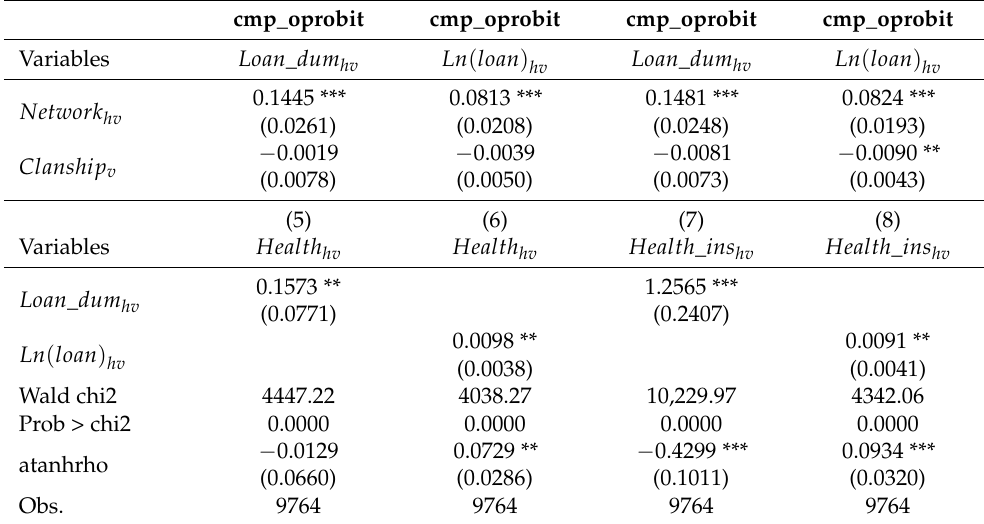
Table 9. Effects of social networks and microcredit on health (subsample regression